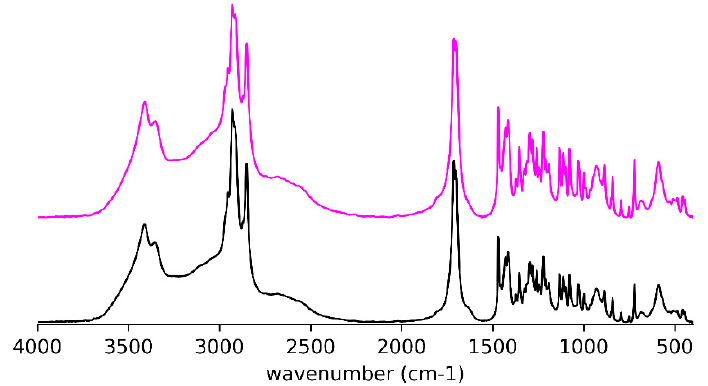
Figure 4. IR spectra for ( R )-10-HSA from acetonitrile (pink trace) and ( R )-10-HSA crystals from a mixture of petroleum ether and ethyl acetate (black trace).